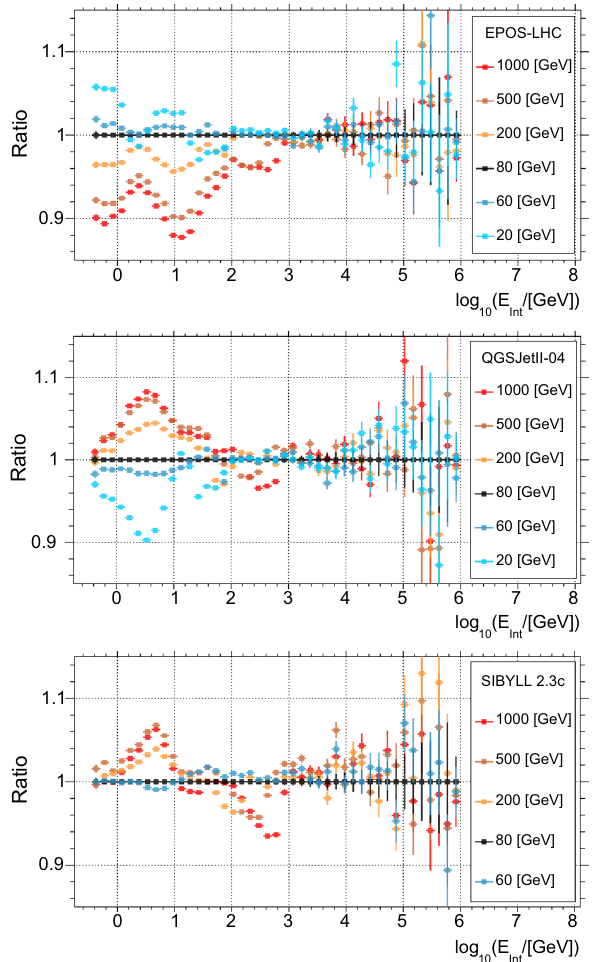
Fig. 11 Ratios between hadronic interaction distributions in PeV pro- ton initiated events with different transition energy values with respect to the default of 80